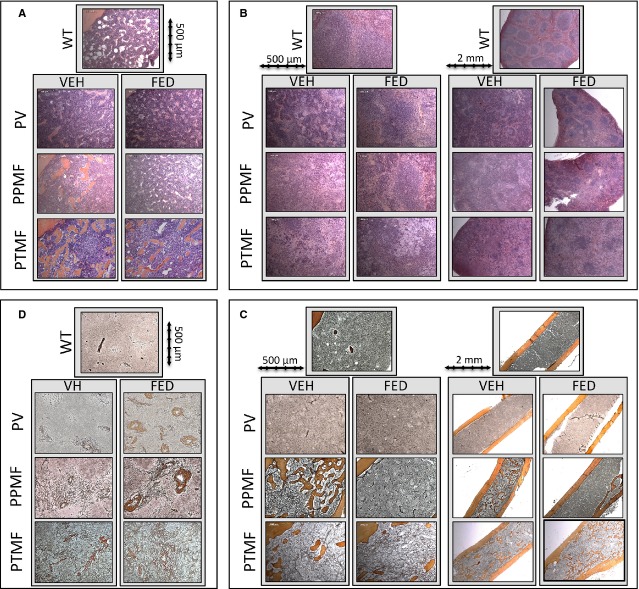
Histology of WT mice and polycythemia vera (PV), post-PV myelofibrosis (PPMF) and rapid post-essential thrombocythemia MF (PTMF) mice treated by Fedratinib or vehicle. BM and spleen were stained with haematoxylin and eosin/safran (HES) (A and B) and silver (C and D). (A) BM HES staining 10× lens. BM osteosclerosis is shown in vehicle-treated PPMF and PTMF mice. Fedratinib-treated PPMF mice do not display osteosclerosis in contrast to Fedratinib-treated PTMF mice. High density of fibrotic tissues responsible for the low cellularity is shown in BM PTMF mice. (B) Spleen HES staining 10× (left) and 2.5× lens (right). Spleen from PV, PPMF and PTMF mice compared to WT mice are characterized by (i) clustered MK, (ii) fibrosis and (iii) hyperplasia of the myeloid red pulp and blending of the lymphoid white pulp areas (×10 lens). Treatment with Fedratinib induced decreased in MK density and appearance of lymphoid areas in PPMF mice, slightly in PTMF mice and especially in PV mice (×2.5 lens). (C) BM silver staining 10× (left) and 2.5× lens (right). No excess fibrosis is shown in WT and PV mice. High-grade BM fibrosis (large deposit of reticulin fibres) and osteosclerosis are shown in vehicle-treated PPMF and PTMF mice. Fedratinib-treated PPMF mice did not display fibrosis and osteosclerosis (n = 7) in contrast to vehicle-treated PPMF mice (n = 5) and Fedratinib/vehicle-treated PTMF mice, day 57 or 70. (D) Spleen silver staining 10× lens. High-grade fibrosis is shown in PV, PPMF and PTMF mice compared to WT mice. Fedratinib treatment did not reduce fibrosis but seemed to worsen it (especially around the blood vessels) in PV and PPMF mice. This effect may be because of shrinking of the spleen in treated animals. Images were obtained (10× or 2.5×/0.3 Zeiss lens) using a Zeiss Axiophot microscope with a Zeiss AxioCam Mrc camera and the AxioVision Rel.4.3 acquisition software (Oberkochen, Germany).